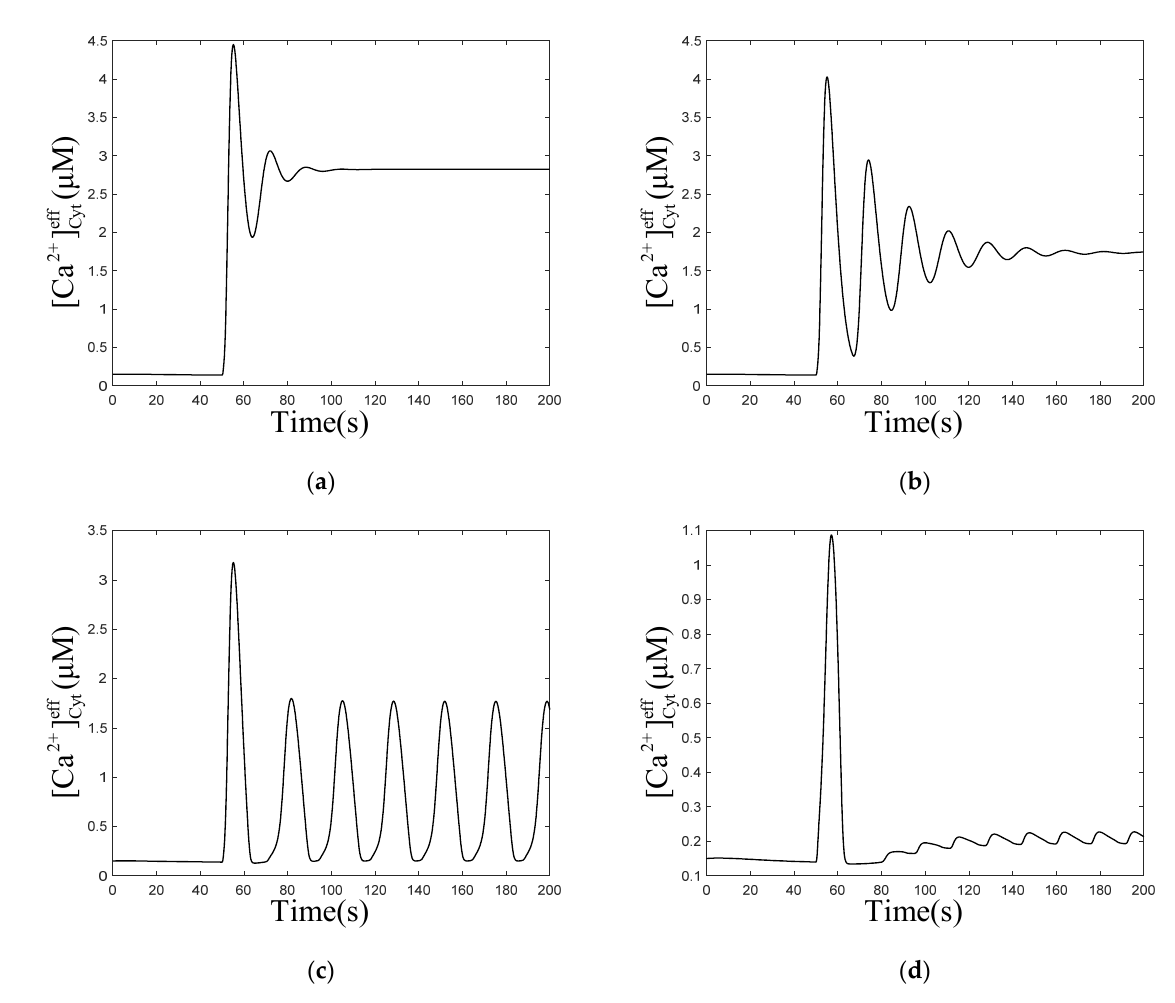
Figure 3. Numerical simulation of the [ Ca 2 + ] of effective cytosolic compartment ( [ Ca 2 + ] ) oscillations with Mt and µ d at the following different values of k deg : ( a ) 0.1 s − 1 , ( b ) 0.5 s − 1 , ( c ) 1.5 s − 1 , ( d ) 5.0 s − 1 , and V PLC = 1 µ M s − 1 , K PLC = 0.12 µ M, K deg = 0.1 µ M, D = 40 nm. Stimulation applied at 50 s. The other parameters and constants are taken from Table 1. ( a , b ) show that after being stimulated, the oscillations restore equilibrium in a very short time. ( c , d ) show that after being stimulated, the oscillations can be maintained for a long time.